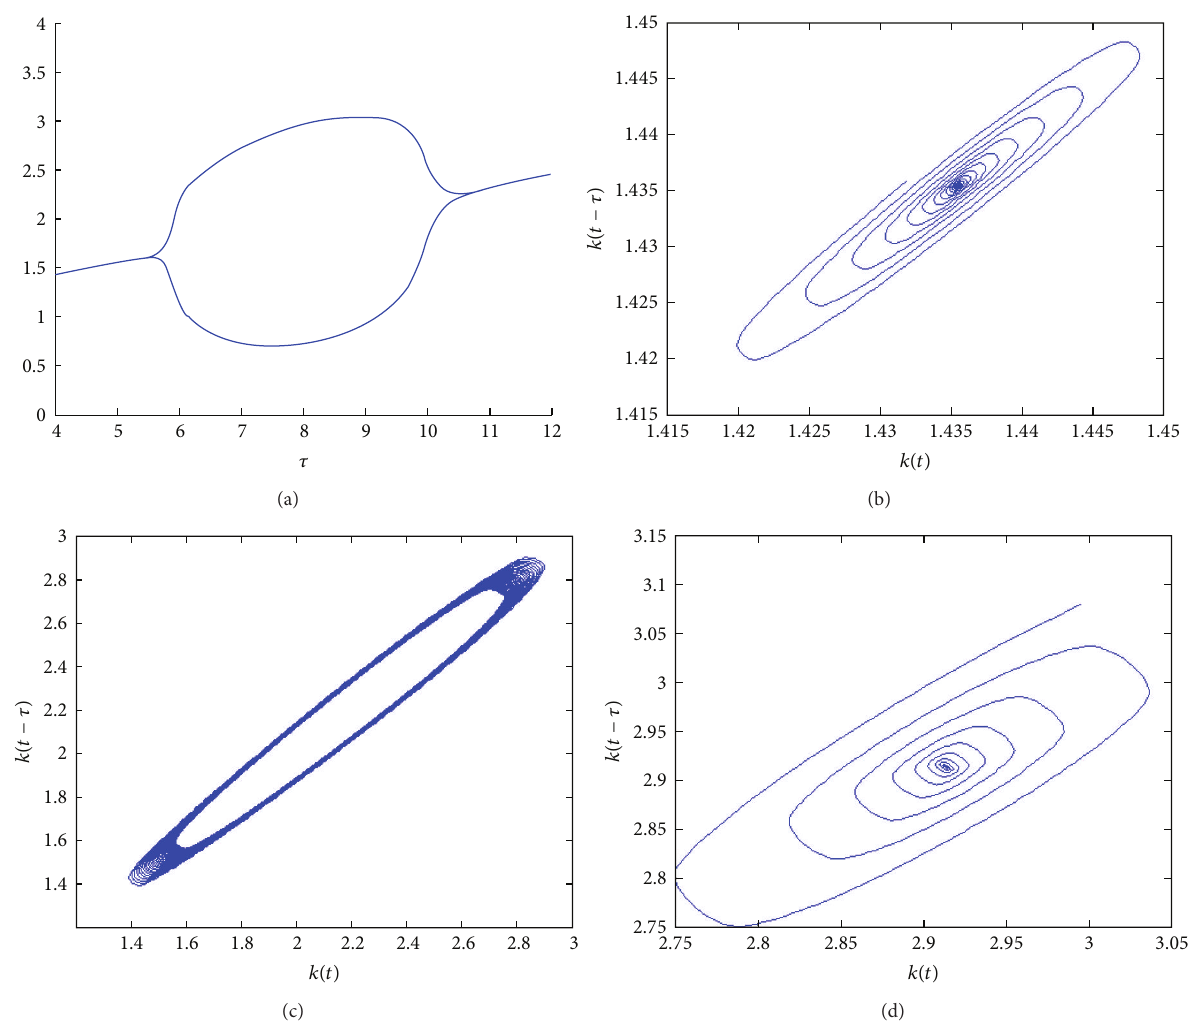
Figure 3: Parameter specification (3): (a) bifurcation diagram with respect to 𝜏 ; (b) phase plane for 𝜏 = 4 ; (c) phase plane for 𝜏 = 10 ; and (d) phase plane for 𝜏 = 15